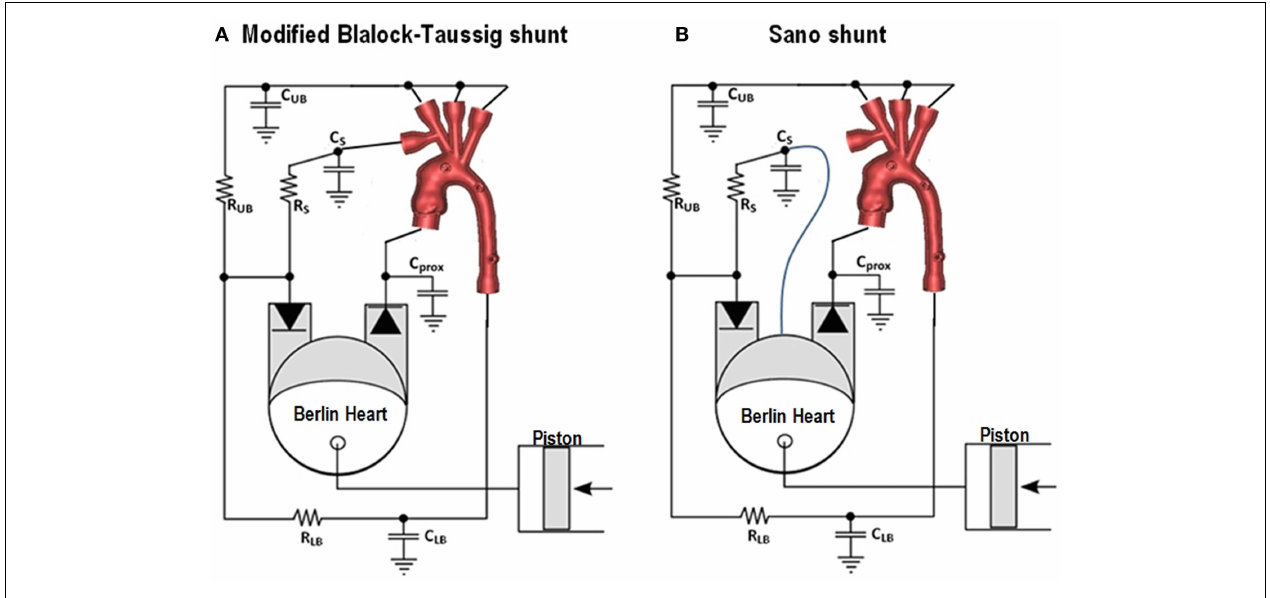
R UB = lumped resistance for upper body district, C LB = lumped compliance for lower body district, R LB = lumped resistance for lower body district, C S = lumped compliance for pulmonary district, R S = lumped resistance for pulmonary district, C prox = proximal compliance compensating for rigid 3D